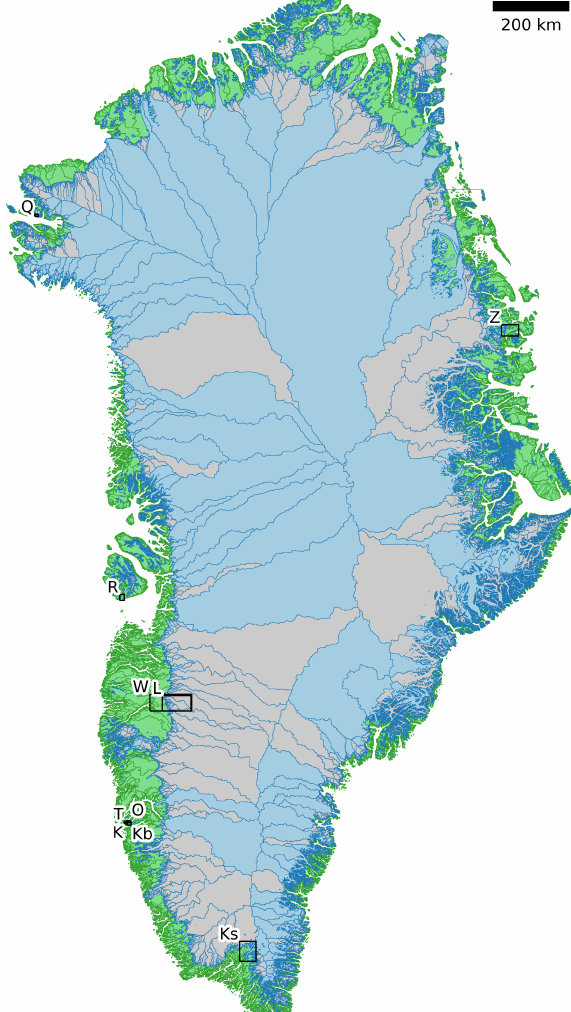
Figure 1. Overview. Map of Greenland showing all basins and the location of 10 gauged streams used for comparison. Land basins are shown in green. Ice basins are shown in blue when outlet elevation < 0 and gray when outlet elevation ≥ 0 (outlet error elevation is discussed in Sect. 4.3.6). Black boxes and labels mark the location of stream gauge observation locations (see Table